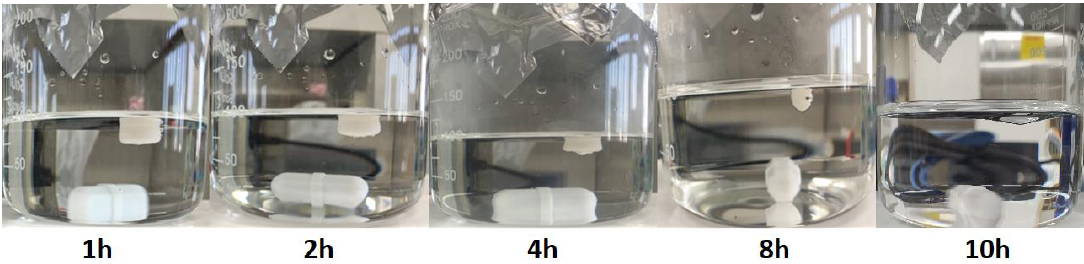
Figure 5. Photographs of 3DP tablet (T2) floating in dissolution medium (0.1 N HCl solution) at room